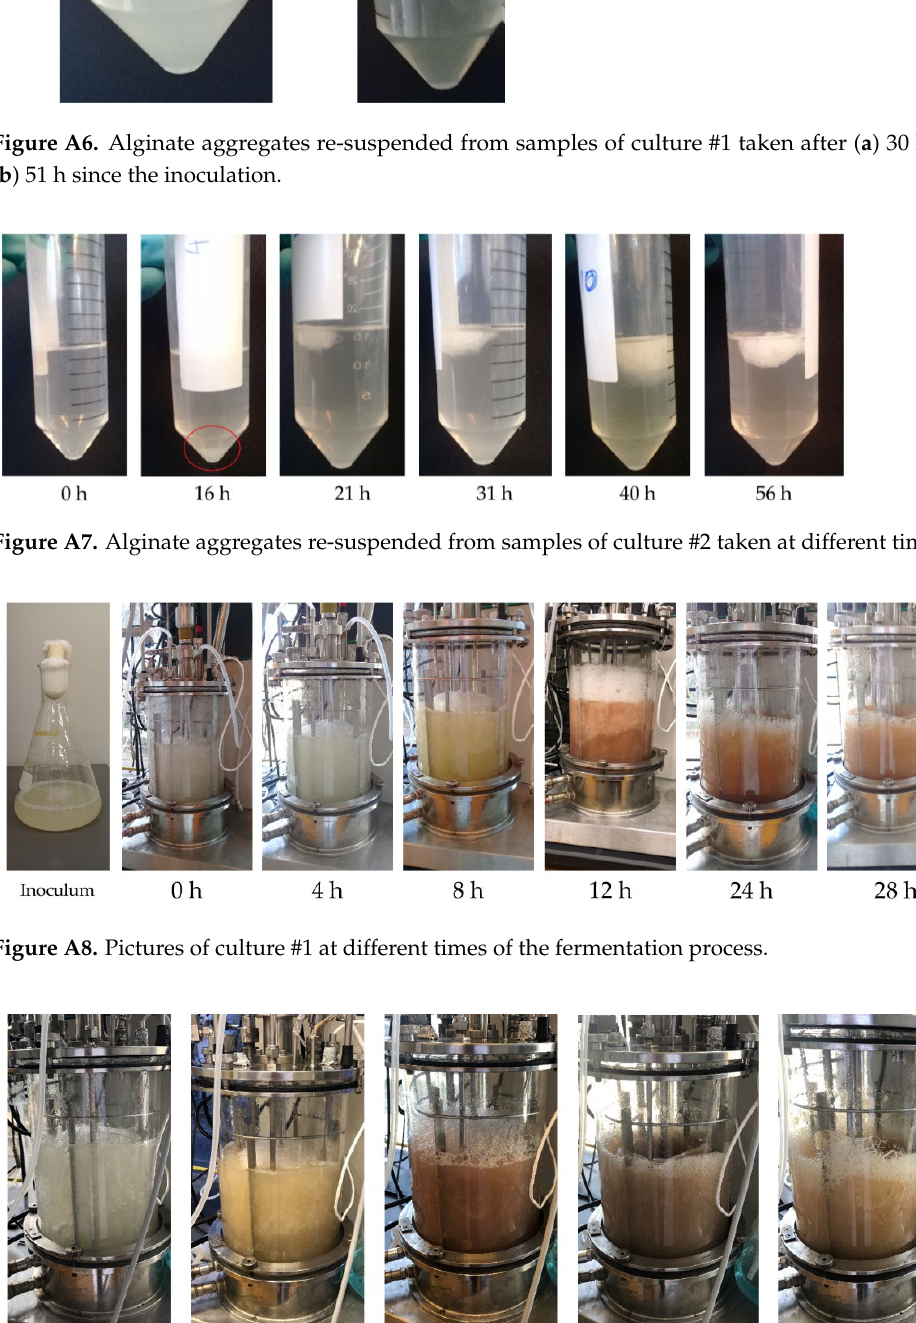
Figure A9. Pictures of culture #2 at different times of the fermentation process.